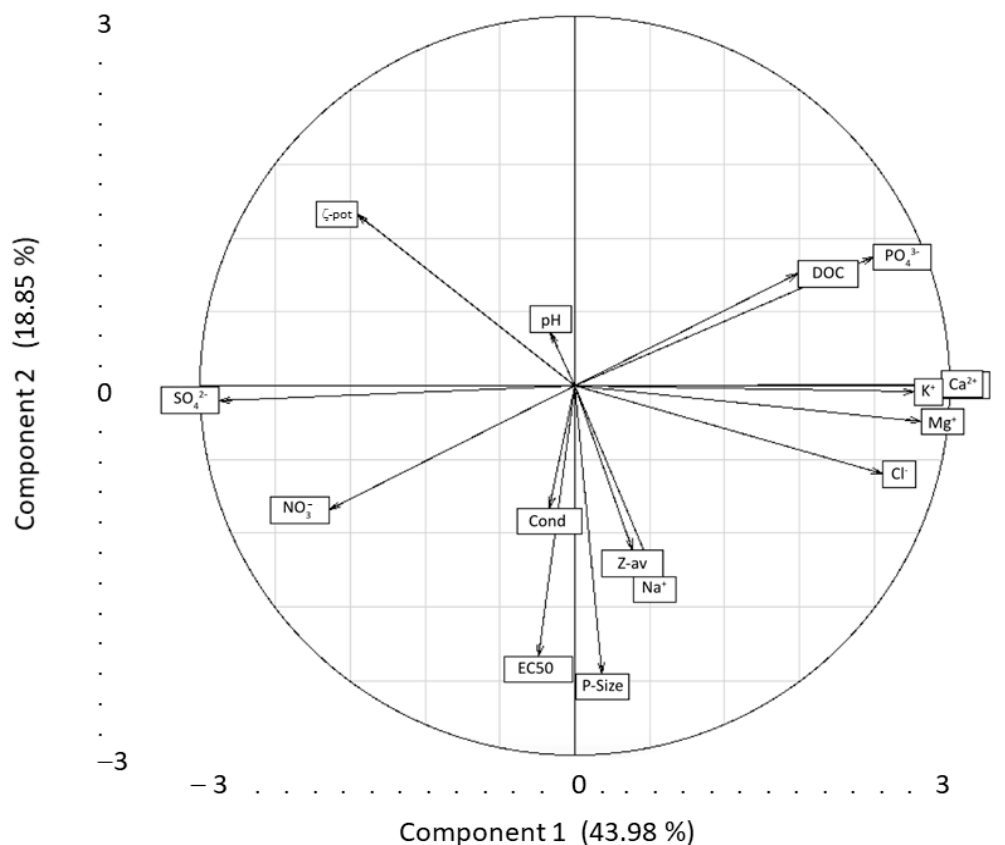
Figure 5. Principal component analysis (first two PCs) between EC 50 obtained in 48-h immobilization test, z-average size (Z-av), ζ -potential ( ζ -pot), primary size (P-Size) of NPLs and different physicochemical characteristics of the exposure media: DOC (dissolved organic carbon), pH, conductivity (Cond), ionic composition, Na + , K + , Ca 2+ , Cl − , NO 3 − , SO 42 − , PO 43 − .